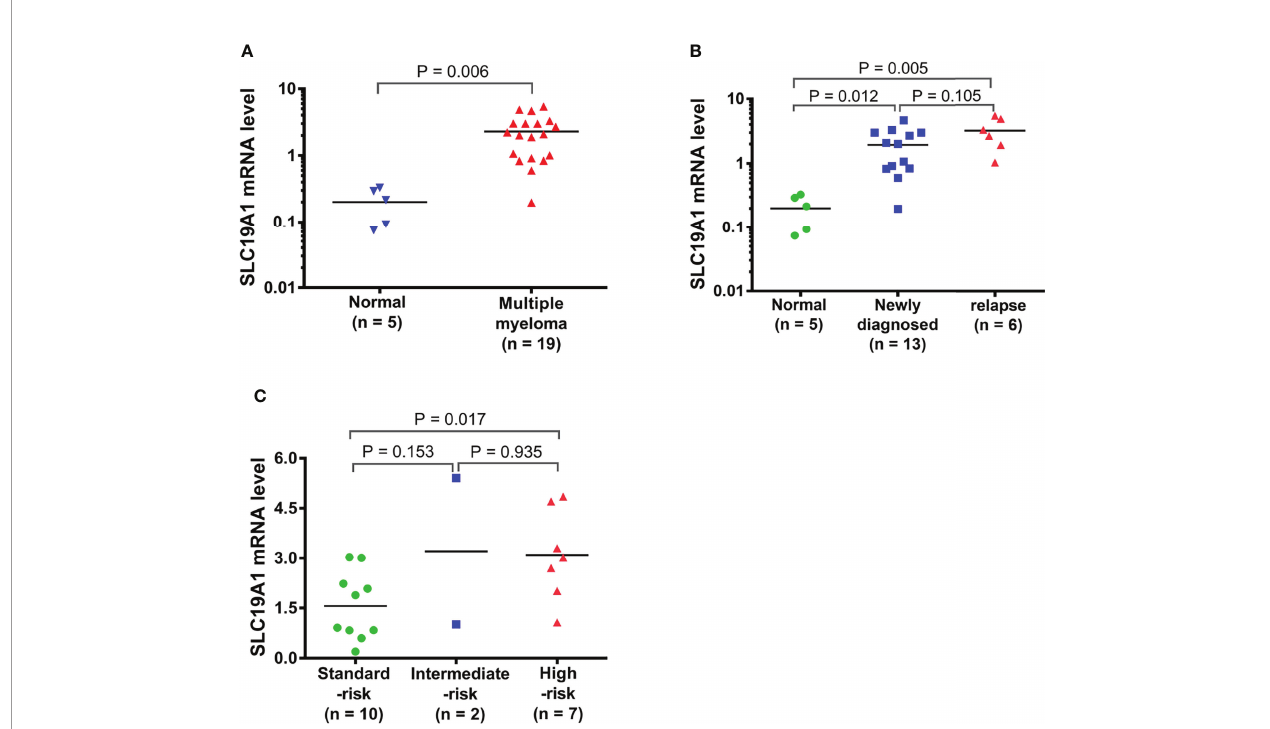
FIGURE 9 | Expression of SLC19A1 in primary MM samples. (A) qRT-PCR analysis of SLC19A1 mRNA expression in MM patient samples ( n =19) and normal controls ( n =5). (B) SLC19A1 mRNA expression in newly diagnosed MM patients ( n =13), relapsed MM patients ( n =6), and normal controls ( n =5). (C) SLC19A1 mRNA expression in different risk strati fi cations. High risk de fi ned as: del 17p, t(14;16), t(14;20), +1q, and del 1p. Intermediate risk de fi ned as: t(4;14), del 13q, and hyperdiploidy. Standard-risk de fi ned as: t(11;14), t(6;14), del 14q (IgH), and others.